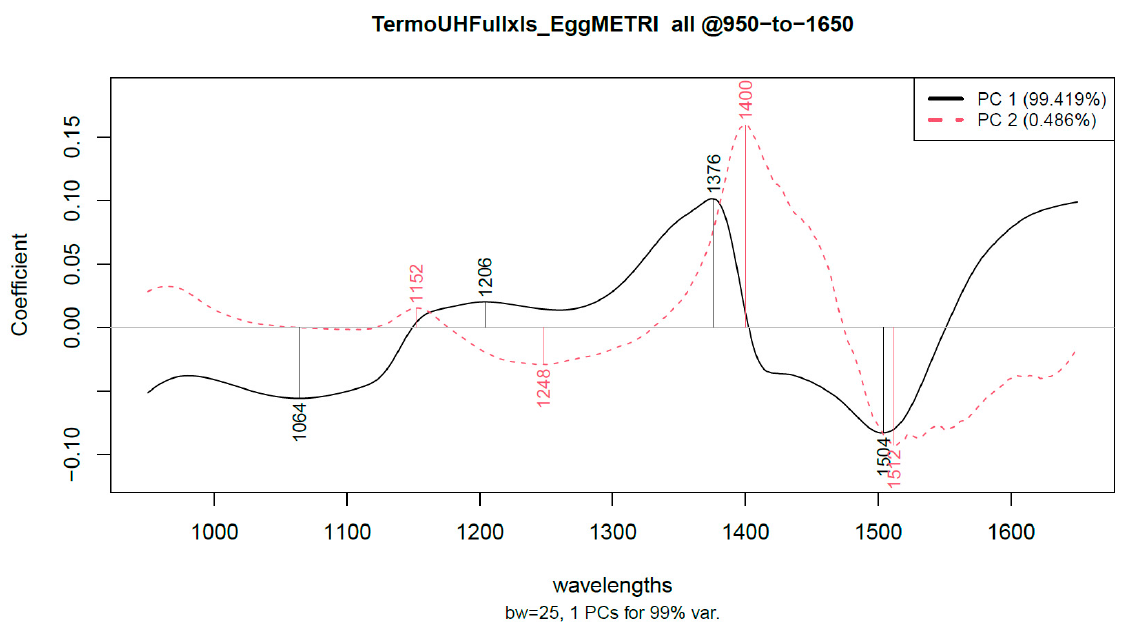
Figure 6. Loading plot of yolk treated at 20 kHz and 3.7 W for 60 min.